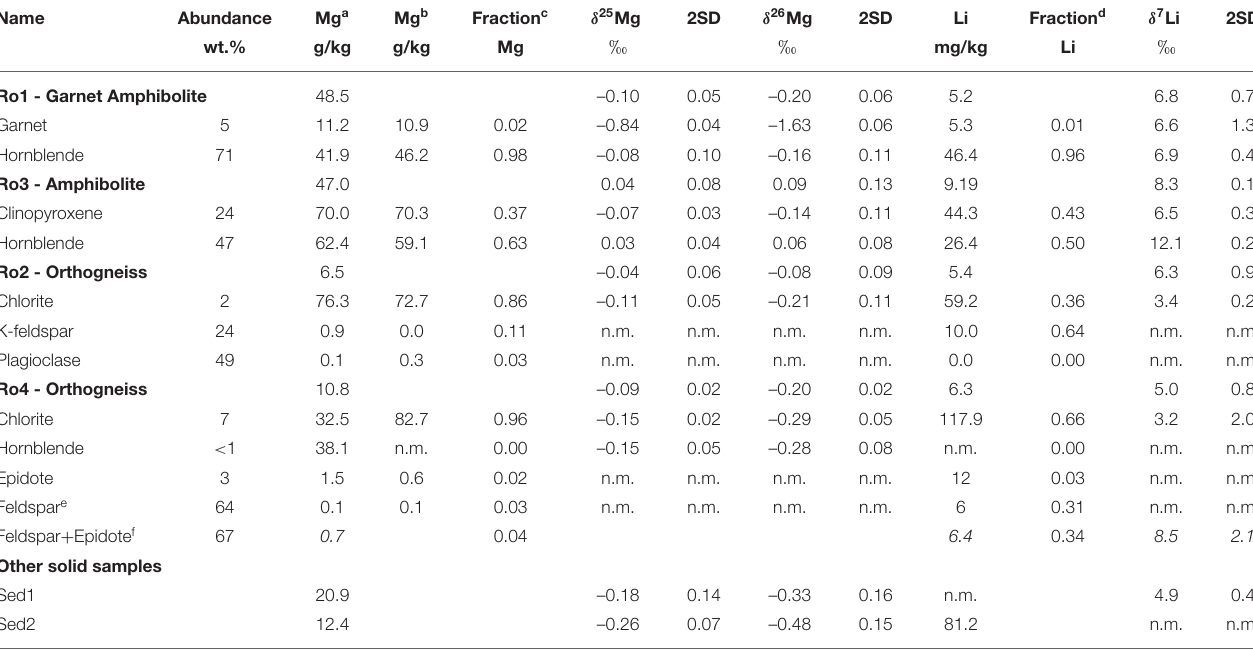
TABLE 1 | Magnesium and lithium concentrations and isotope ratios of rocks, mineral separates, and river sediment